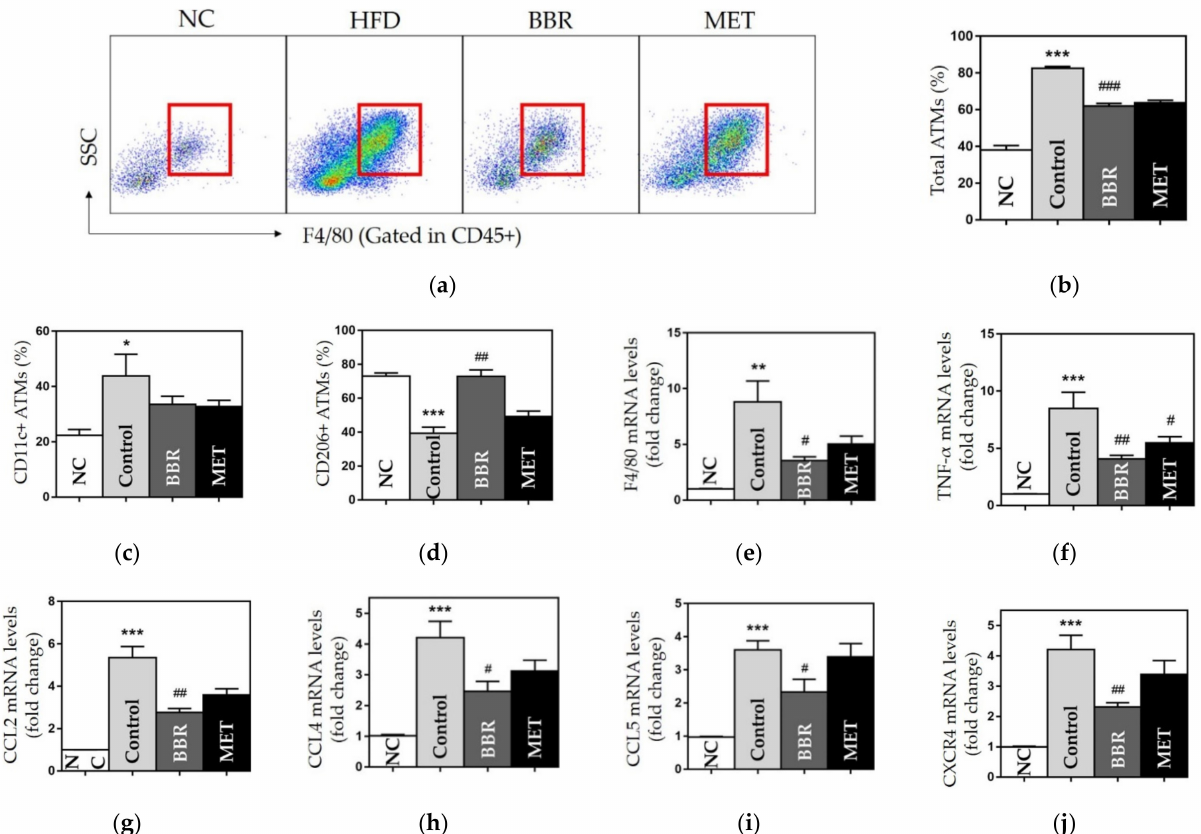
Figure 4. The population and polarization of ATMs and the gene expressions of chemokines. ( a ) Flow cytometry results and gating strategy of CD45+ & F4/80+ ATMs (red box); the popula- tions of ( b ) CD45+ & F4/80+ ATMs; ( c ) CD11c+ ATMs; ( d ) CD206+ ATMs; and the gene expressions of ( e ) F4/80; ( f ) TNF- α ; ( g ) CCL2; ( h ) CCL4; ( i ) CCL5; and ( j ) CXCR4. Data are presented as mean ± standard error of the mean (SEM). * p < 0.05, ** p < 0.01 and *** p < 0.001 vs. the NC group and # p < 0.05, ## p < 0.01 and ### p < 0.001 vs. the control group. ATMs: adipose tissue